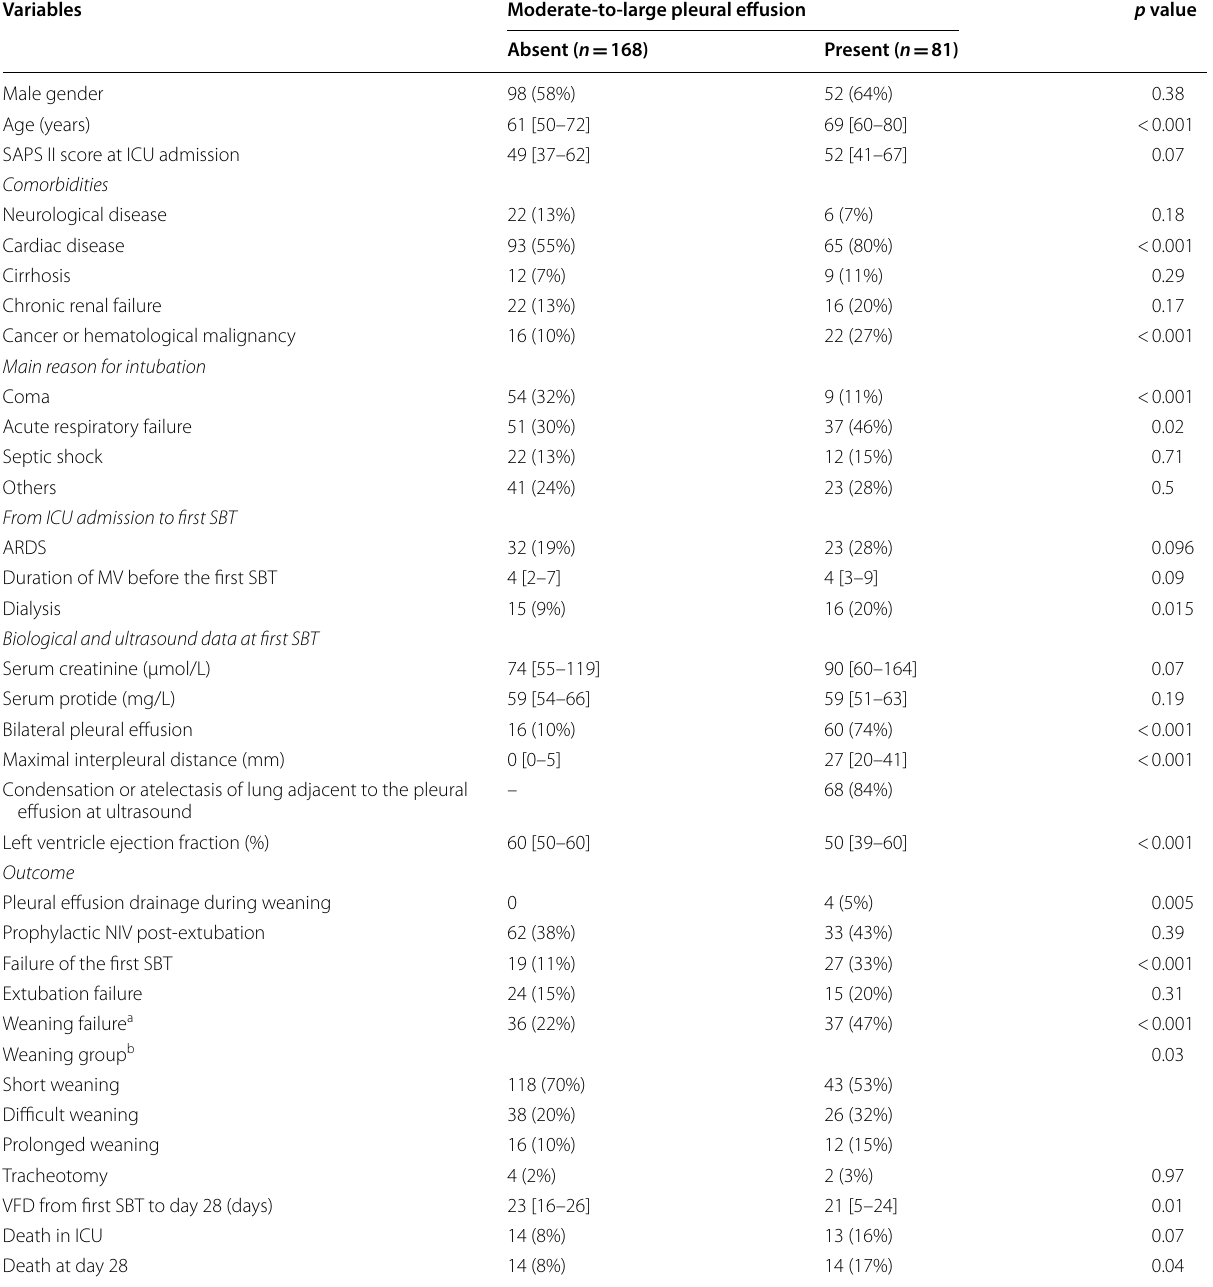
Table 2 Characteristics and outcome of 249 mechanically ventilated patients with or without moderate-to-large